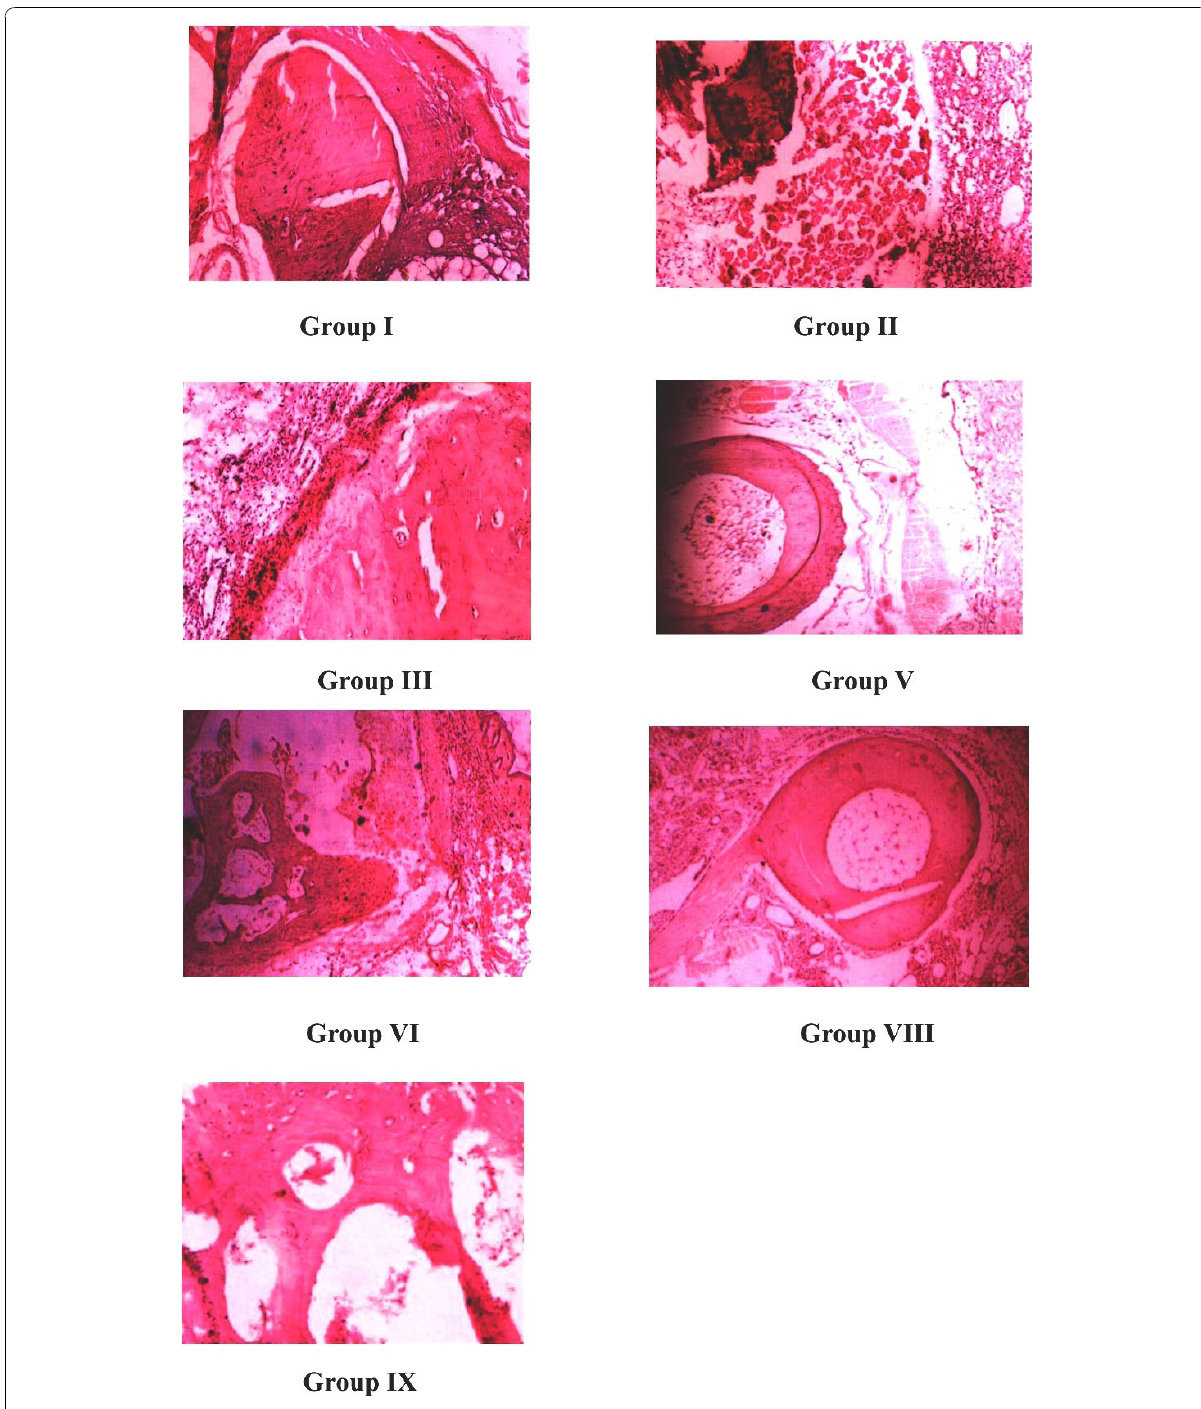
Figure 2 Histopathology of proximal interphalangeal joints on adjuvant induced arthritic rats